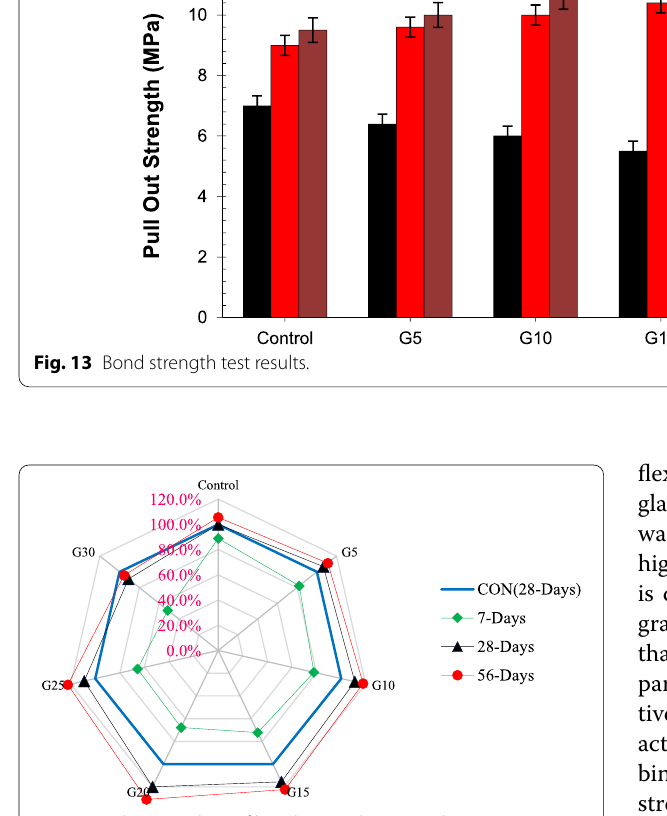
Fig. 14 Relative analysis of bond strength test